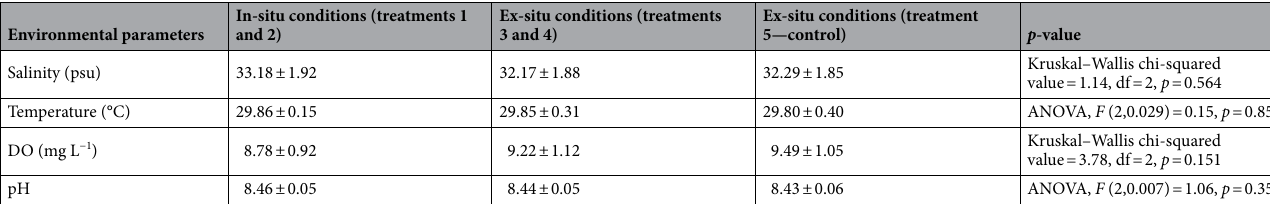
Table 1. Comparison of key environmental parameters in the field (in-situ) and aquarium (ex-situ) culture over a period of 3 months (weeks 0–12) (mean ± S.D.; n =